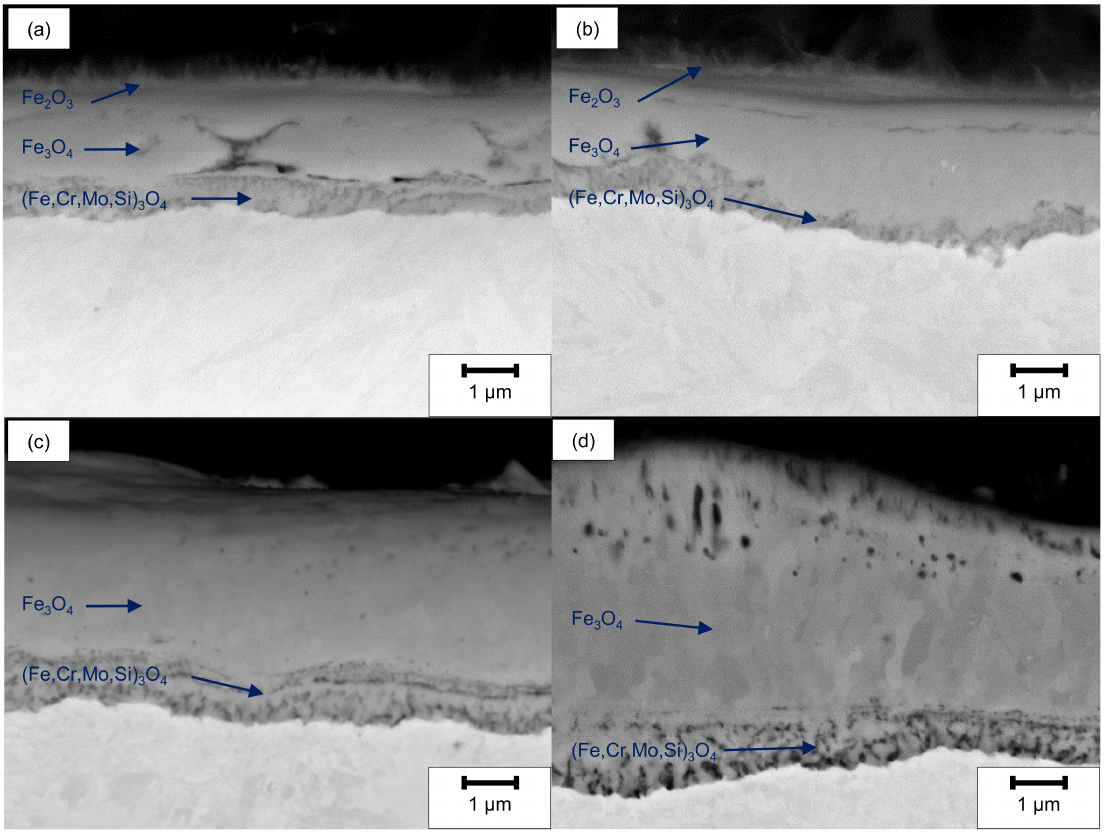
Figure 10. SEM cross-section images after oxidation of ( a ) ground, ( b ) LCM-H 3 PO 4 -6W, ( c ) LCM-NaNO 3 -6W and ( d ) LCM- NaNO 3 -18W 42CrMo4 steel at 500 ◦ C for 20